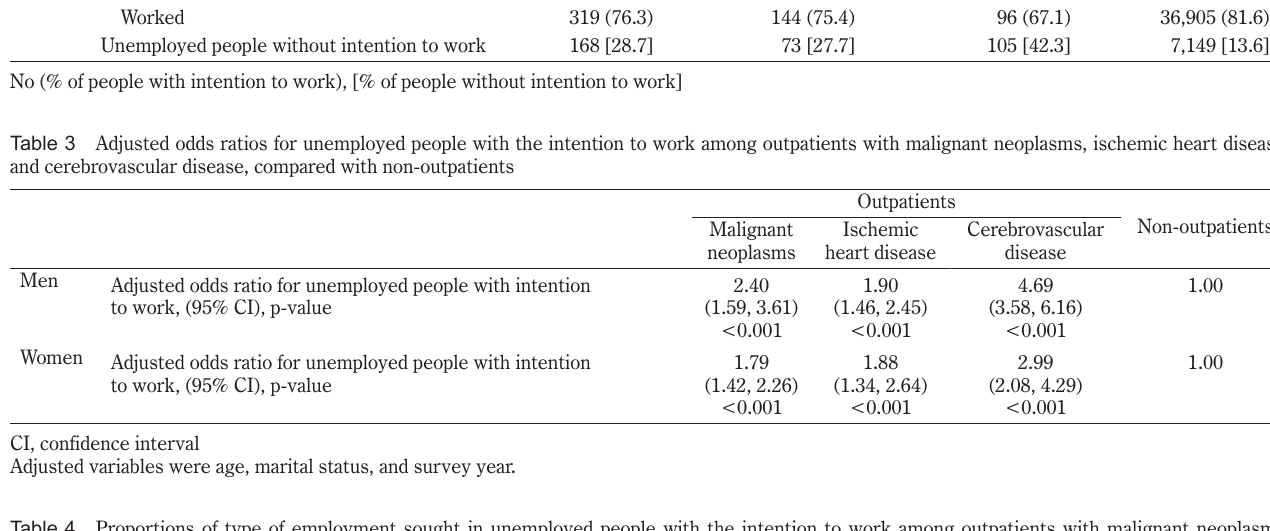
Table 4 Proportions of type of employment sought in unemployed people with the intention to work among outpatients with malignant neoplasms, ischemic heart disease, and cerebrovascular disease, and non-outpatients